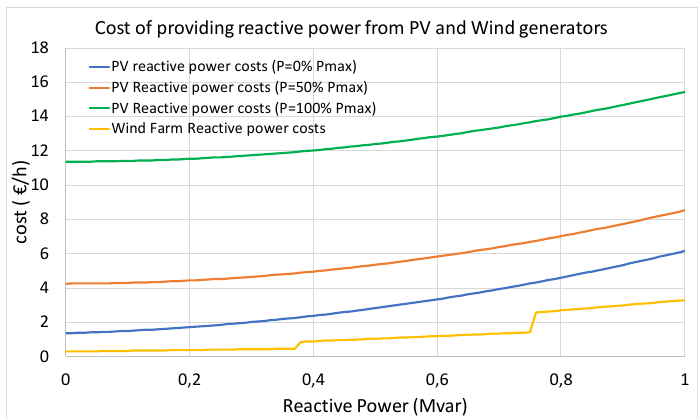
Figure 5. Costs of providing reactive power for PV and wind farms.